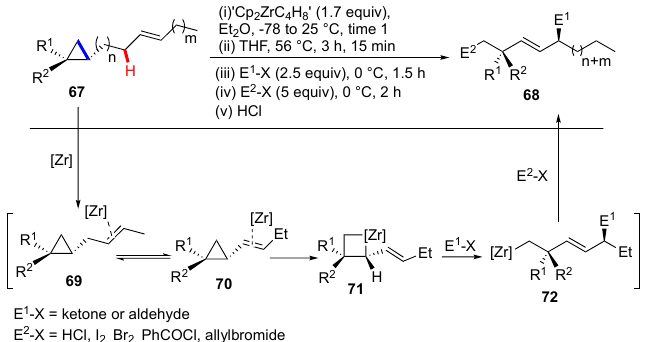
Scheme 9. Zr-mediated functionalization of ω -ene-cyclopropane